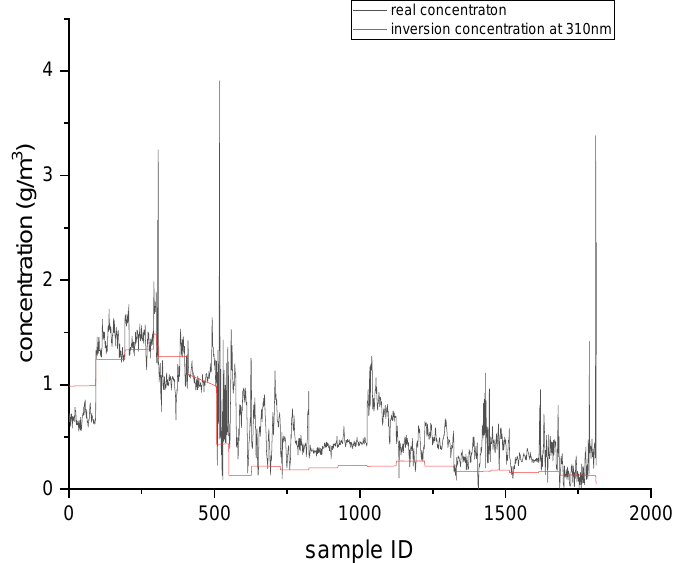
Figure 7. Single-wavelength inversion results at 300 nm.